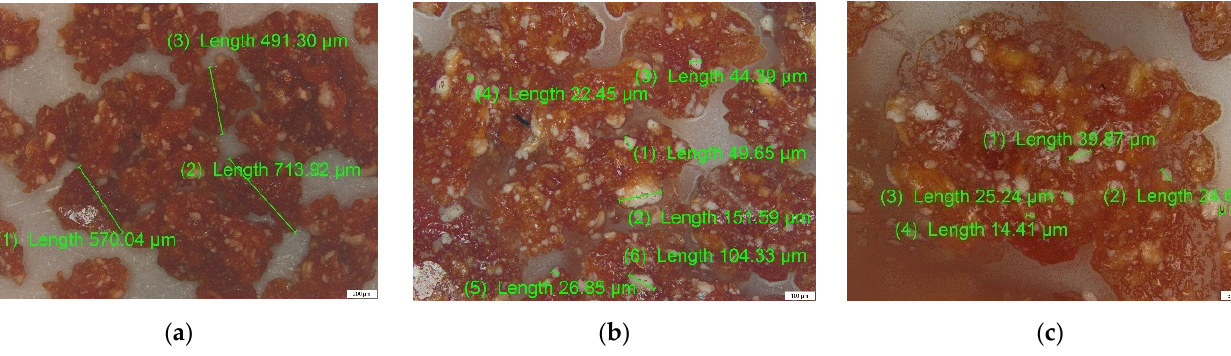
Figure 10. Optical microscopy analysis for CS–BPA (1:1) microbeads: ( a ) 50×, ( b ) 100×, and ( c ) 200× magnification.